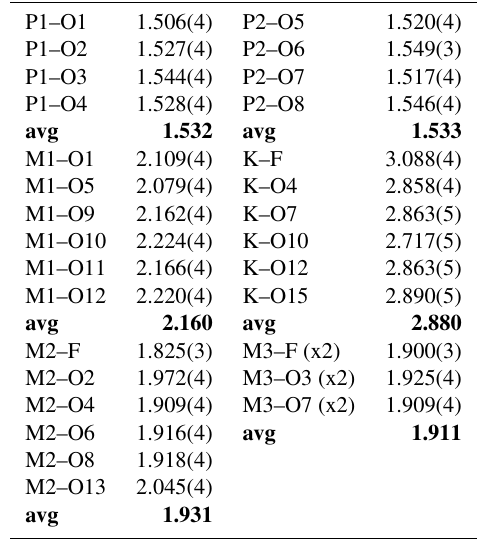
Table 5. Polyhedral bond lengths [Å] for